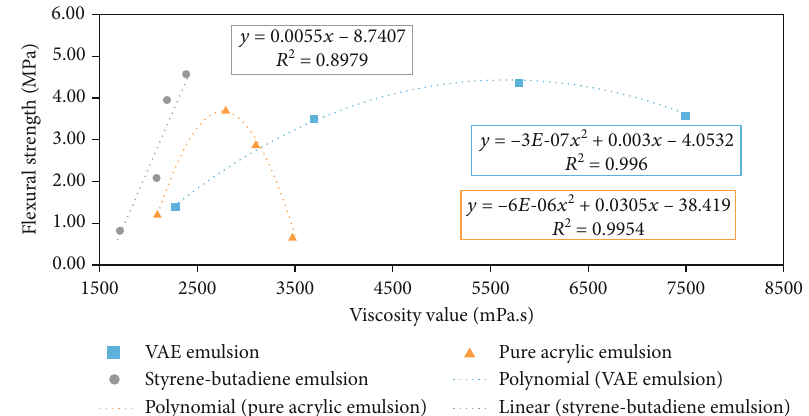
Figure 12: The relationship between the viscosity of three TSL materials and the fl exural